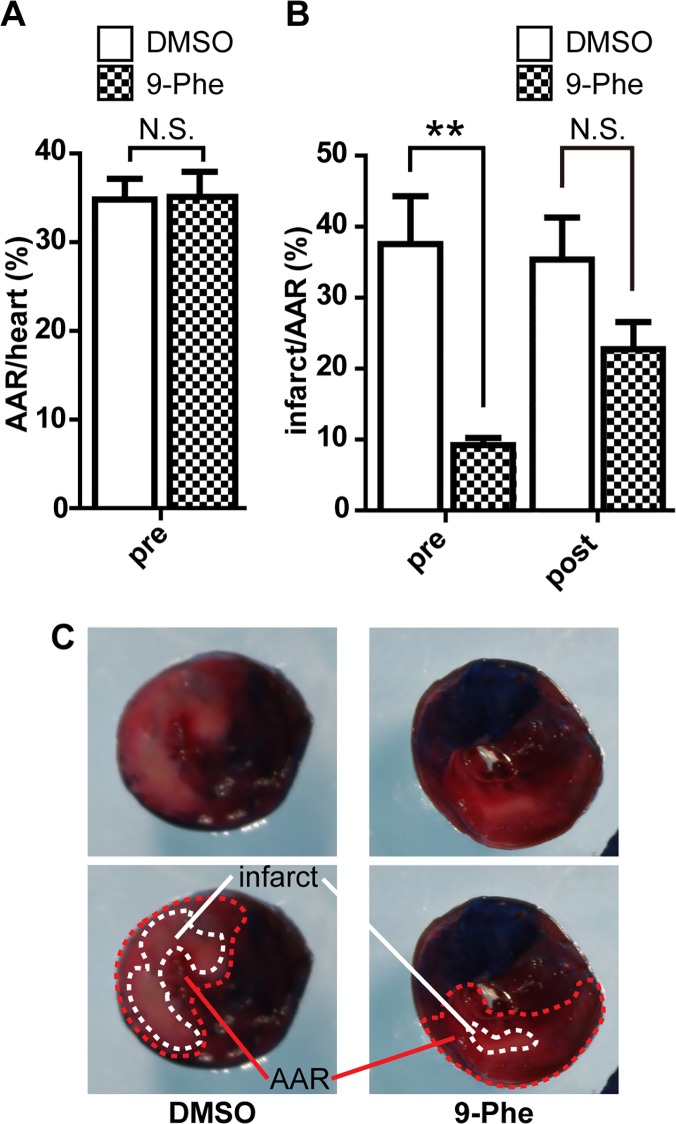
Impact of 9-Phe on the size of myocardial infarction.Rats received a bolus injection of DMSO (control) or 9-Phe before (preconditioning) or after (postconditioning) ischemia during an ischemia/reperfusion (I/R) protocol. (A) Impact on the percentage of area at risk (AAR) caused by I/R. (B) Impact on the percent infarct size over AAR. A fixed detection threshold for infarcted area was arbitrarily set, and used throughout the analysis. Only 9-Phe preconditioning significantly reduced the percent infarcted size, compared to DMSO (n = 5–6; p < 0.01). (C) Typical TTC-stained heart slices after preconditioning with DMSO or 9-Phe. The blue region indicates cardiac tissue that received normal blood flow, whereas the red region indicates ischemic tissue due to LAD occlusion. The light red region encircled by a dotted line indicates the infarcted tissue.